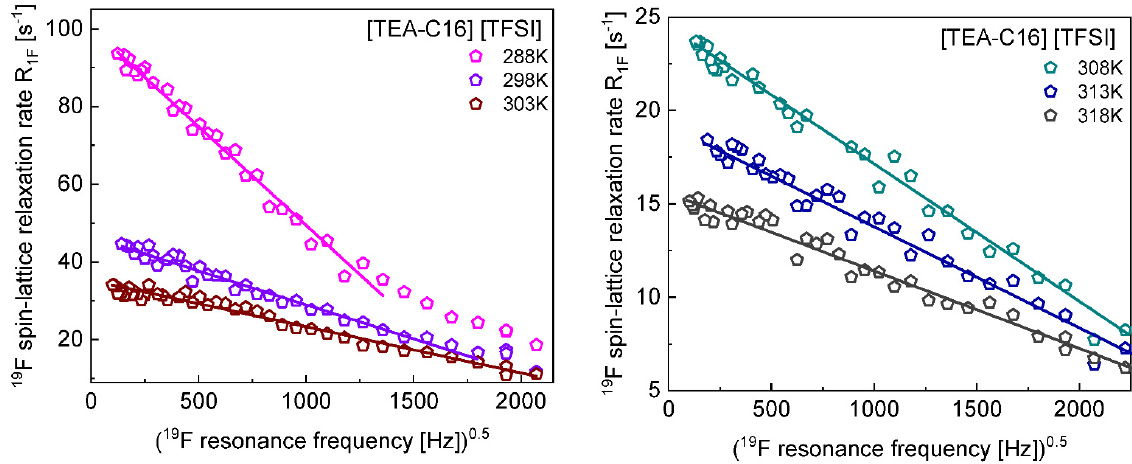
Figure A5. 19 F spin-lattice relaxation data for [TEA − C14] [TFSI] versus the squared root of the resonance frequency; solid lines represent linear fits in the low frequency range.